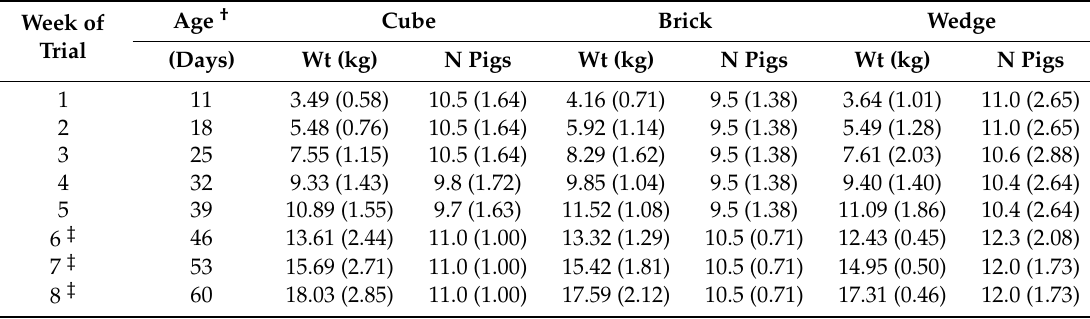
Table 3. Live weight of pigs and group (litter) size details for each block shape treatment during the experiment. Week 1 refers to week 1 on experiment, which commenced when piglets were about 10 days old. In replicate 1, the groups remained on treatment for 8 weeks, whereas in replicates 2 and 3, the groups remained on treatment for 6 weeks. Values shown are means ( ± std